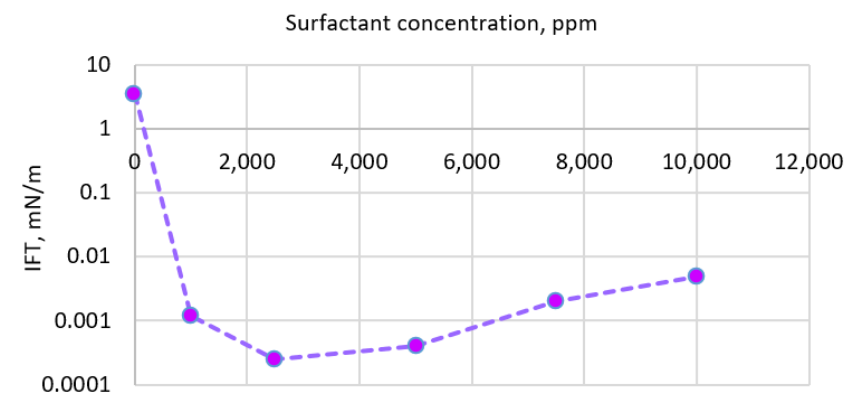
Figure 6. Dependence of interfacial tension on surfactant concentration.